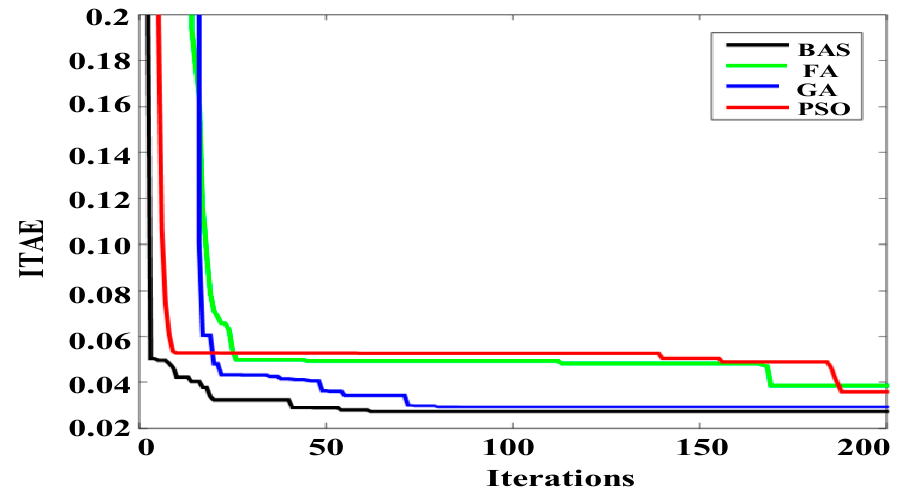
Figure 5. Average convergence curves of ITAE.